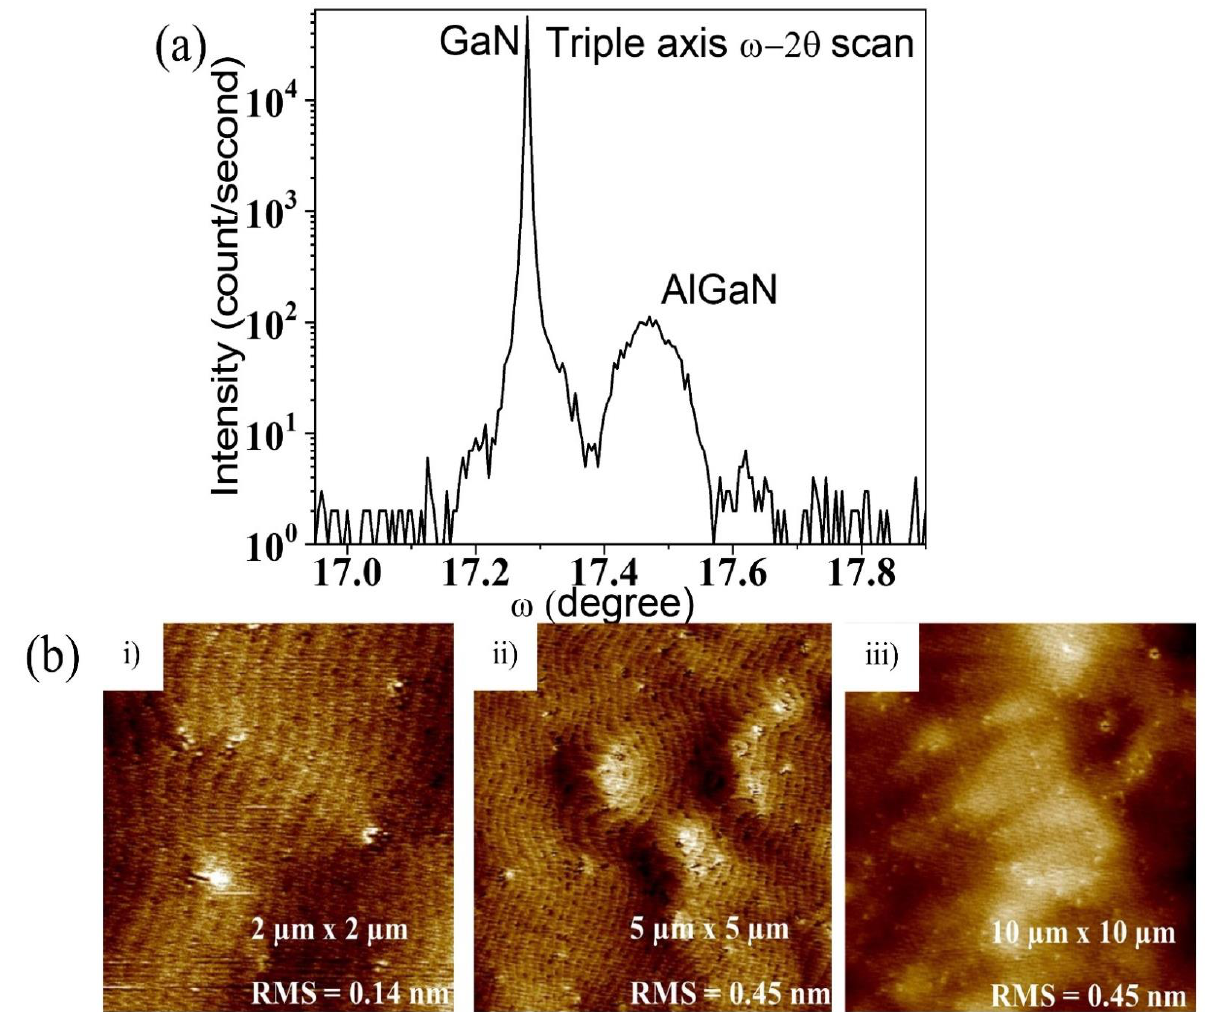
Figure 2. ( a ) XRD data for ω -2 θ XRD scan for AlGaN/GaN heterostructure and ( b ) 2D AFM images for the surface of AlGaN/GaN heterostructure at different magnifications.